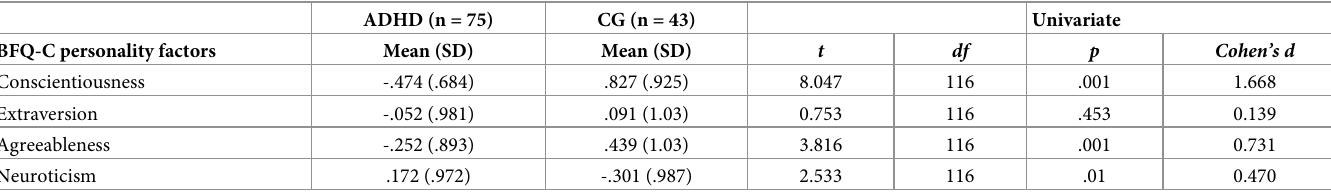
Table 2. Means, standard deviation, Cohen’s d effect size and MANCOVA analysis of ADHD and control groups on BFQ-C self-report measures.